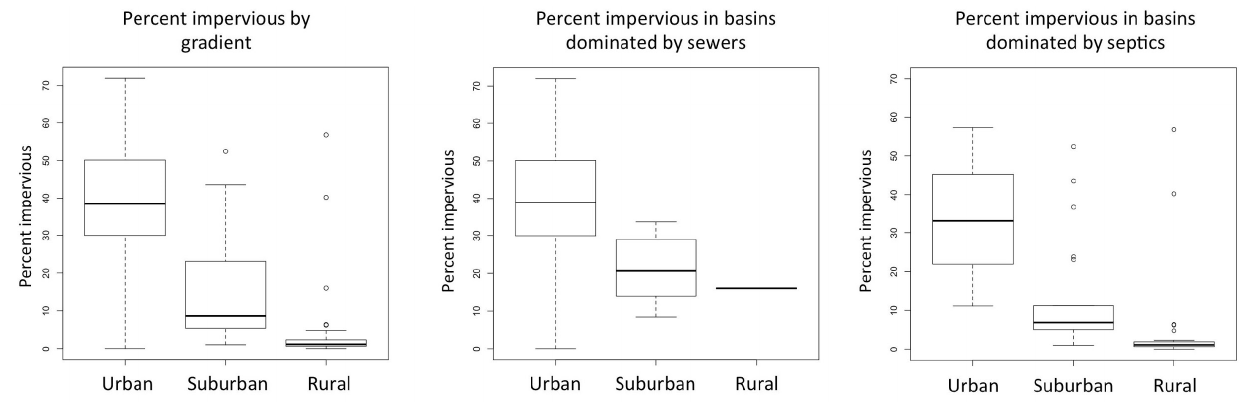
Figure 7. ( a ) Percent impervious across all watersheds; ( b ) percent impervious in sewered parcels; ( c ) percent impervious in septic parcels. Source of graphs: Spirandelli, 2014